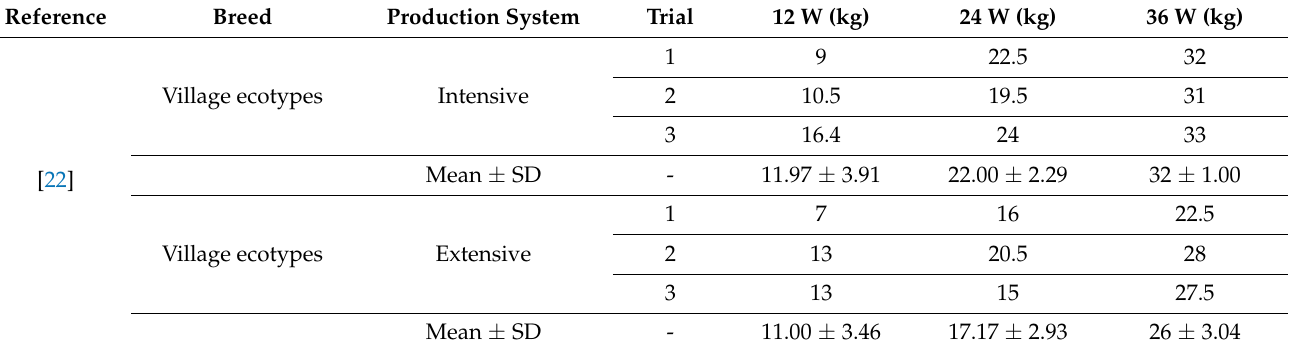
Table 2. Three different growth stages of village goats under two different production systems